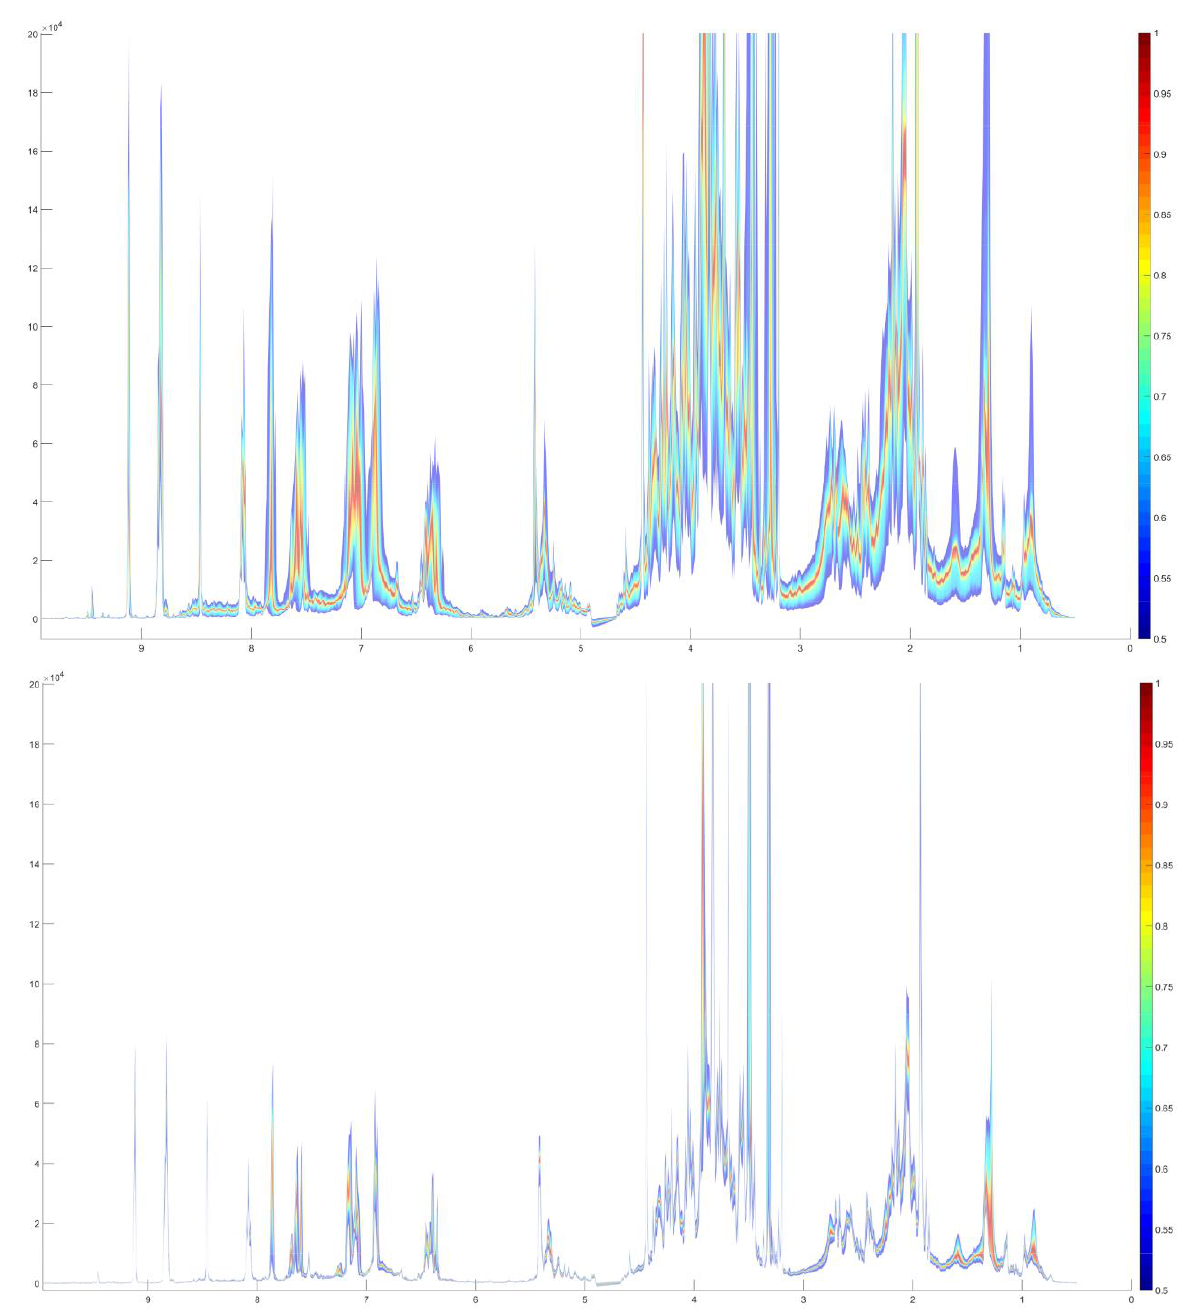
Figure 10. Quantile plots of NMR spectra of hot (upper panel) and cold brew coffees (lower panel).